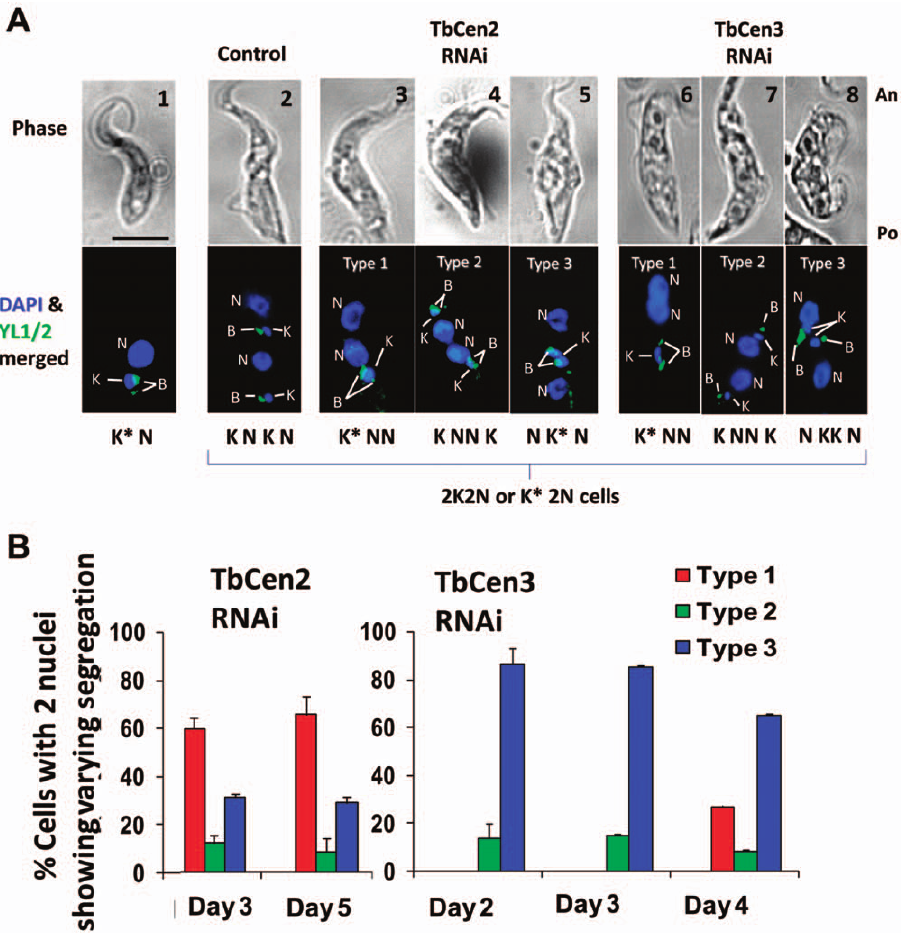
Figure 4. Images show direct effect of centrins’ depletion on kinetoplast biology and overall organelle segregation in T.brucei . A : Segregation patterns of the basal bodies along with the kinetoplasts during RNAi for TbCen2 and 3. The cells were stained with DAPI for nuclei and kinetoplasts and YL1/2 for basal bodies. Panels 1 and 2 display the typical segregation of basal bodies, kinetoplasts and nucleus in the control cells. Panels 3–5 and 6–8 display the 3 different segregation patterns of the organelles after RNAi of TbCen2 and 3 respectively, other than the typical pattern seen with the control cells (panel 2). Panel 1 is the ‘G’ stage of the cell cycle of the procyclic form with 1K1N, where both the basal bodies and kinetoplast are seen at the posterior region of the cell. Scale bar common for all the images, 5 m m. B : Histogram of cells with 2 basal body pairs displaying each of the 3 new segregation patterns of basal bodies and kinetoplasts in the RNAi cells. For each TbCen2 and 3 RNAi studies, over 100 bi- nucleated cells with abnormal organelle segregation were manually counted and analyzed. Data represent the means 6 SD of three independent experiments. The time points at which the cells analyzed after induction was day 3 for TbCen2 RNAi cells and day 2 for TbCen3 RNAi cells. An, anterior end; B, basal body; K, kinetoplast; N, nucleus, Po, posterior end. Scale bars, 5 m m.